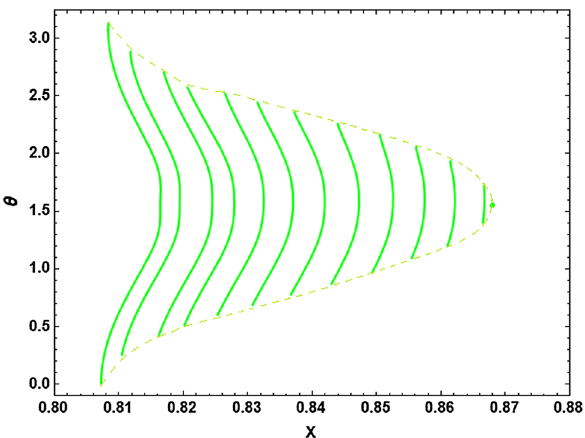
Fig. 5 a Projection of the unstable invariant manifold (green lines) associated with the periodic orbits (red lines) for η = − 2. The dark regions are the forbidden regions for photons and the black dot represents observer. b Poincaré section in the plane ( θ, p θ ) for the unstable manifold (green) with η = − 2 at the observers position. The angle θ (60 ◦ and 90 ◦ ) marked near two dash lines denote the inclination angle of observers. c , d Correspond to the shadows observed by the observer with the inclination angle θ obs = 60 ◦ and θ = 90 ◦ , respectively. The obs white line is for fixed η = −